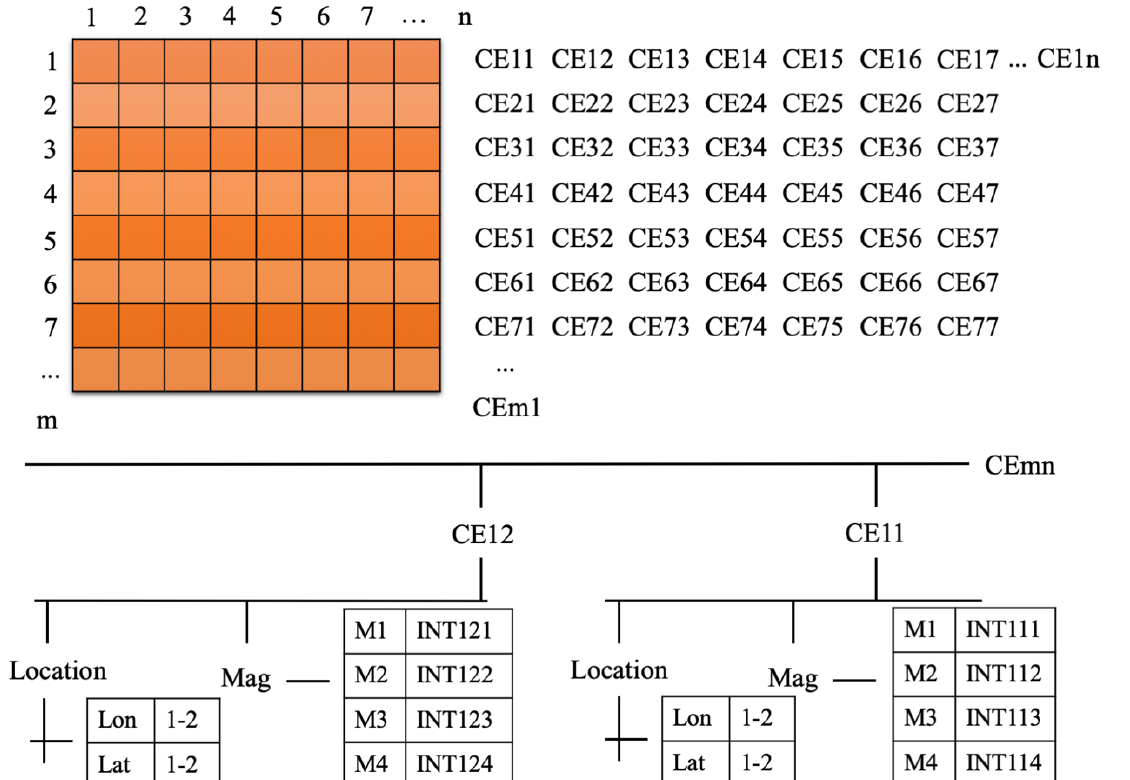
Figure 8. The framework of MMI Database (MMID, shortened as ID) to be used in the EEW2.0. The establishment of an integrated ID could be divided into three steps: (1) Grid the whole protected area with 0.2° × 0.2° grids; (2) assign a unique label to each cell, i.e., CEmn, 1 ≤ m, n ≤ 16, and m, n are always integers. For example, CE11 stands for the cell at the first row and the first column, and CE1338 stands for the cell at the 13th row and the 38th column. (3) At each cell, two fields are assigned. The first field is location, including the longitude and latitude range; the second field is the classification of magnitudes. For example, in the cell CE11, the classification of magnitudes includes four classes, i.e., M1, M2, M3, M4 (maybe more, in practice). Each magnitude class refers to a unique prepared MMI result labeled by INTmnX, matching the unique MMI result prepared for the Xth magnitude class in the cell at the mth row and the nth column, e.g., assumed an M = 7.0 earthquake occurred in CE11, and 7 is in M3 class, then the earthquake could quickly match the prepared MMI result INT113 in the MMI